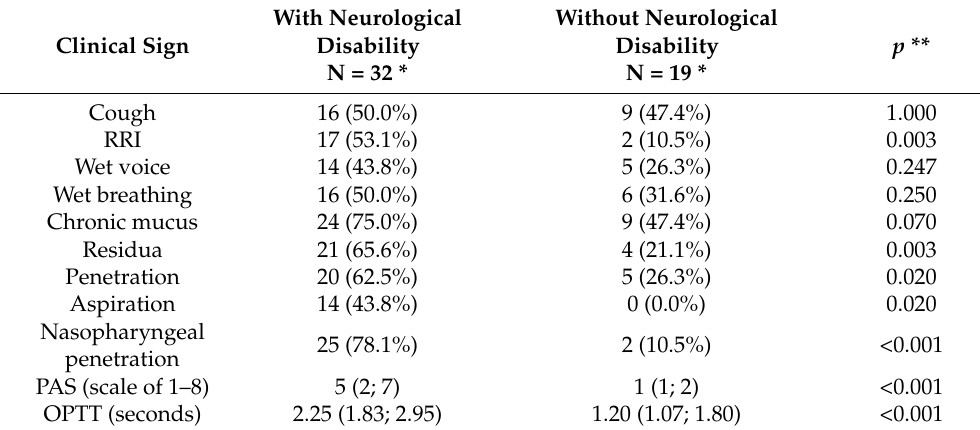
Table 8. Incidence of clinical signs in groups with and without neurological